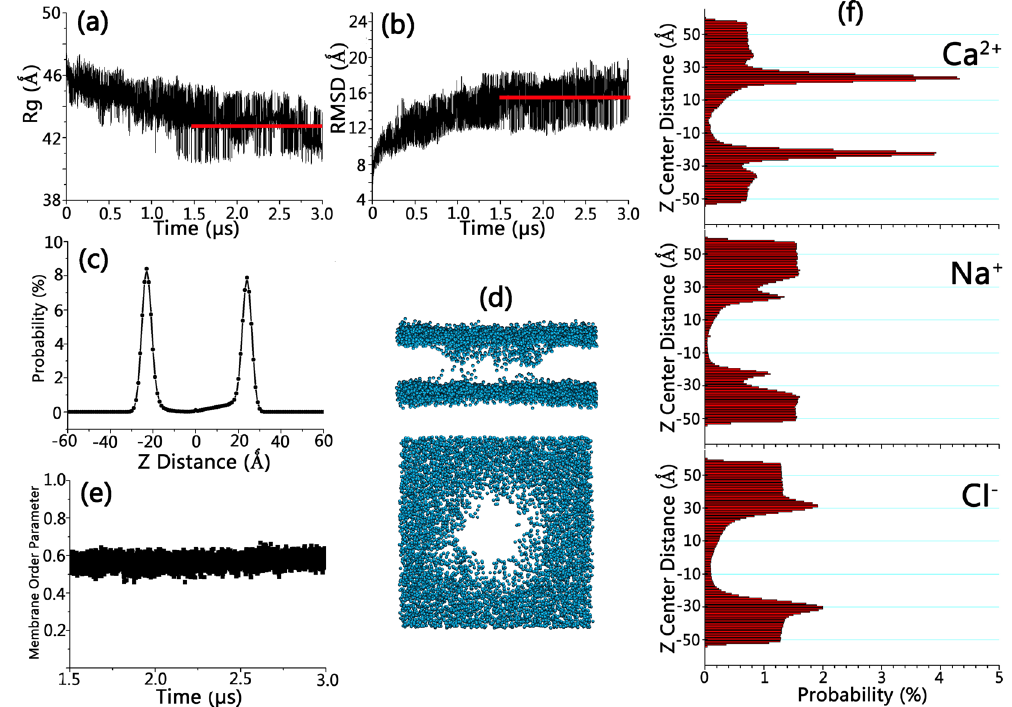
Figure 2. Time-dependent Rg and RMSD profiles for Bax oligomeric pores and cytochrome C ( a , b ), distribution probability profile for PO 4 groups of the lipids ( c ), superimposed snapshots for PO 4 groups of the lipid bilayers ( d ), membrane order parameter ( e ), and the distribution probability profiles for ions ( f ). Z distance: vertical distance to pore center alone the pore